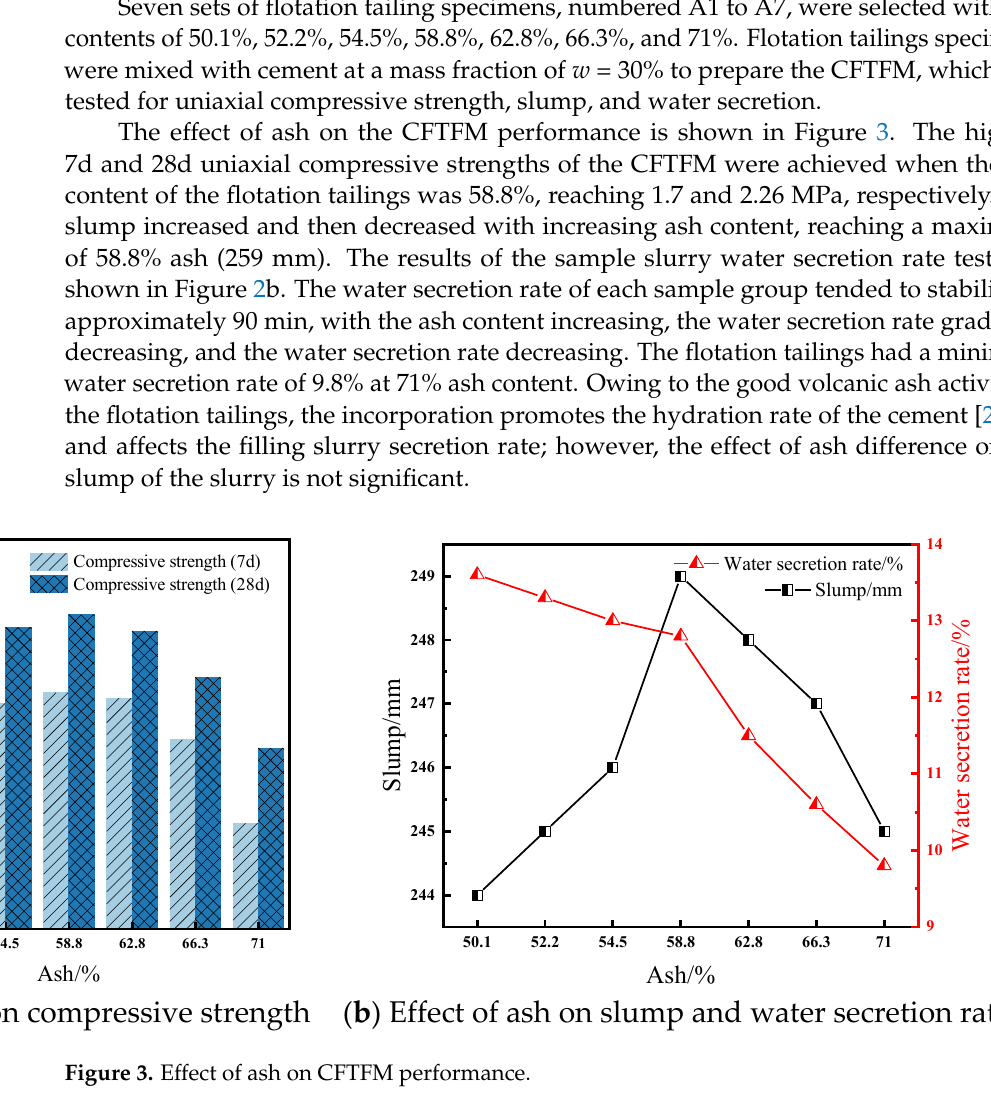
Table 3. Specimen hydration exotherm test protocol.